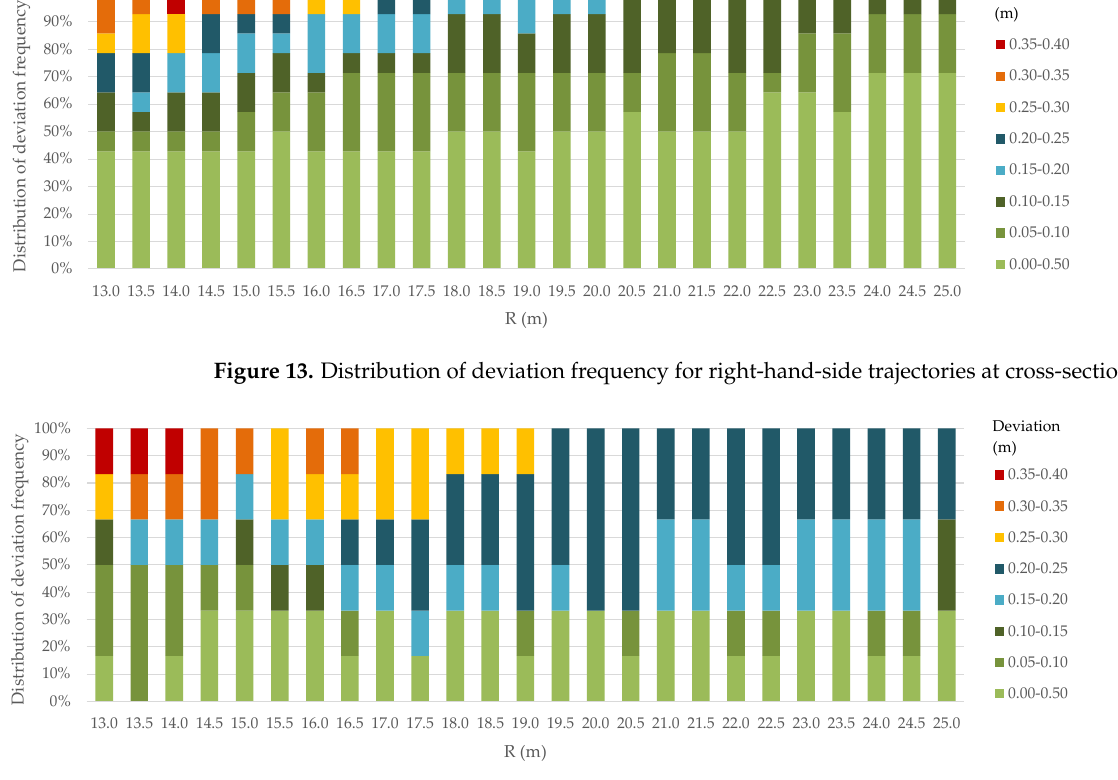
Figure 12. Distribution of deviation frequency for right-hand-side trajectories at cross-sections 1–3.